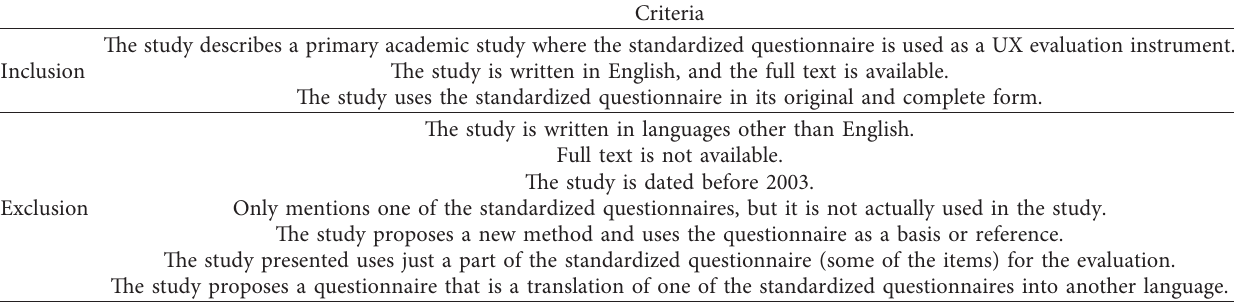
Table 1: Inclusion and exclusion criteria.